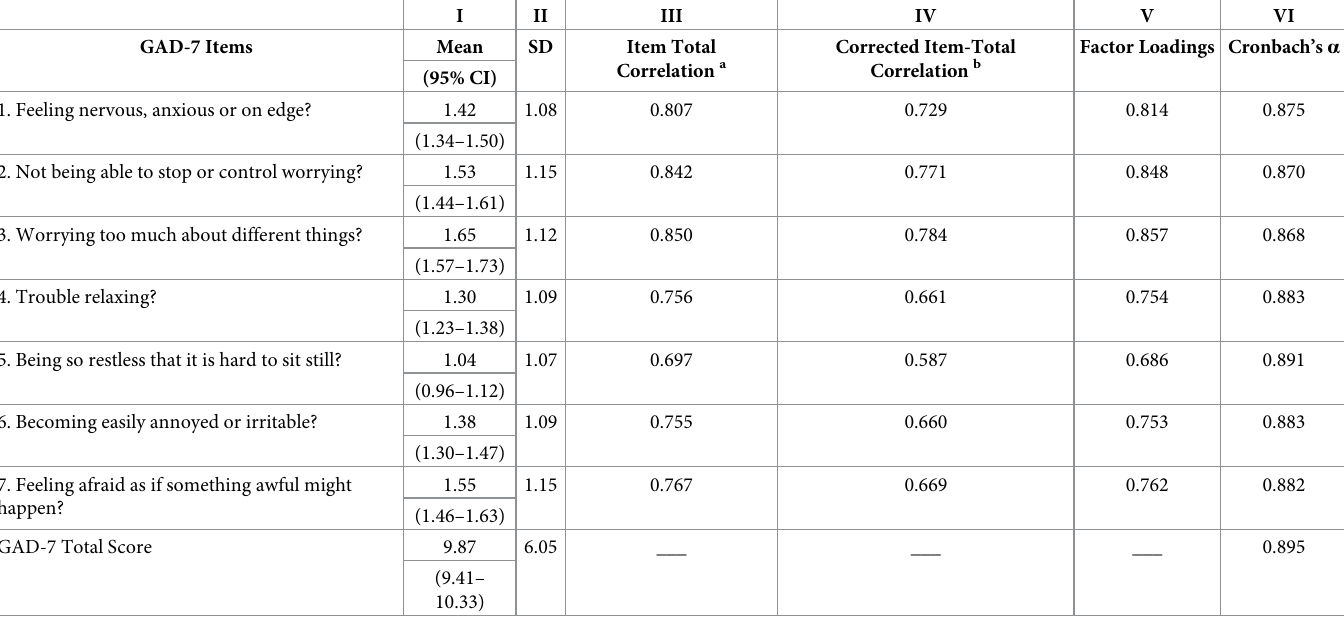
Table 2. Characteristics of items and total GAD-7 scale.